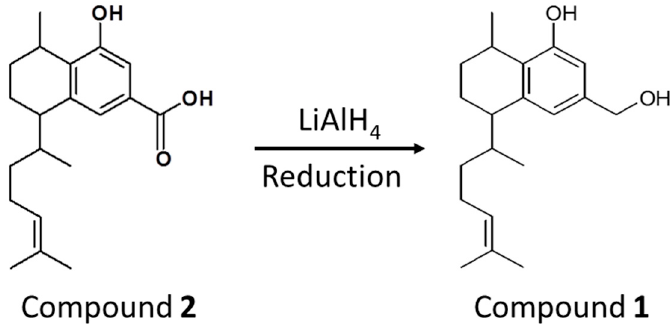
Figure 4. Reduction of compound 2 to compound 1.